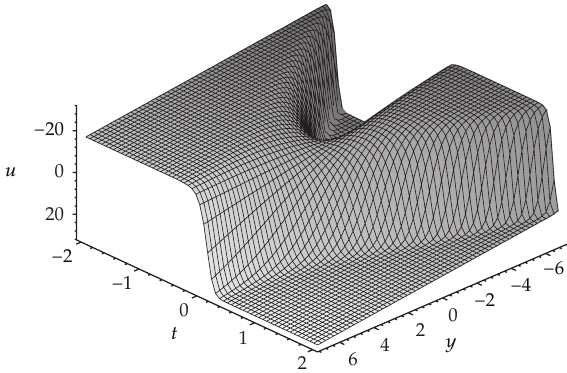
Figure 3: Local structure of 𝑢 2 (𝑥,𝑦,𝑡) is shown as 𝑥 = 1 , 𝛼 = 1 , 𝛽 = 10 , 𝑝 = −1 , 𝑞 = 1 , and 𝛾 = 6 .